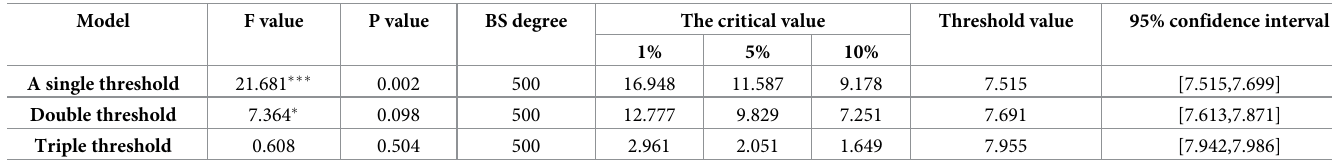
Table 4. Threshold effect test of apple production